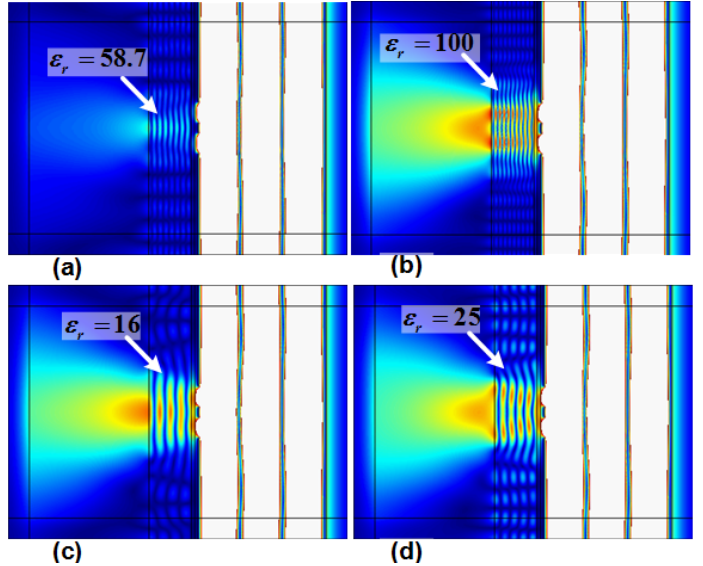
Figure 5. Projection of the two slits with the proposed two-layer structure for various values for the dielectric layer: ( a ) ε r = 58.7; ( b ) ε r = 100; ( c ) ε r = 16; ( d ) ε r = 25.